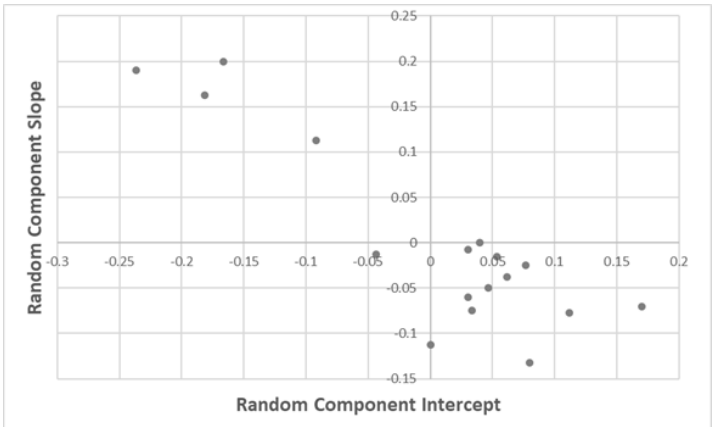
Figure 5. Relationship between random period effects of slope and